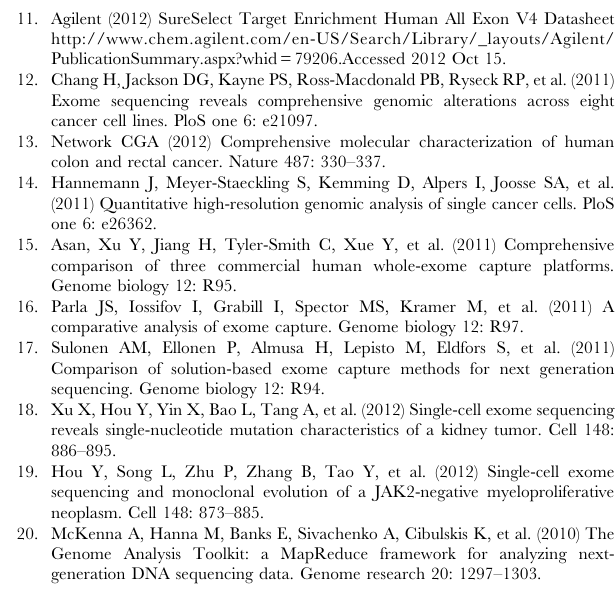
Table S1 Summary of fitted regression line functions, with associated R 2 correlation values, for all patients. Table S2 Fractions of bi-allelic genes for the unamplified and WGA sequence